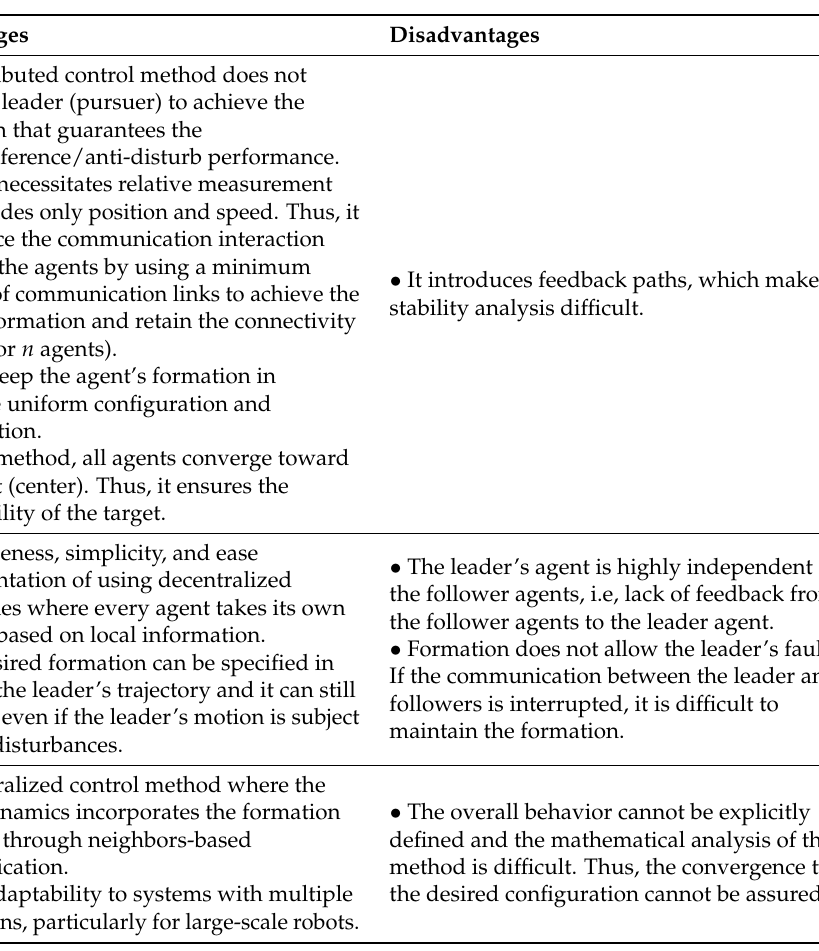
Table 2. Comparison of circular formation control